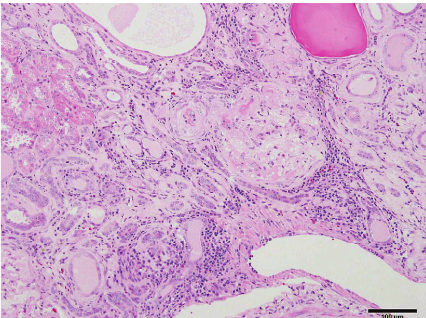
F 4: Histological analysis. HE stain. Severely progressed glomerular and tubulointerstitial lesions in male SDT fatty rat at 60 weeks of age ere are completely sclerotic glomeruli and atrophic tubules with many in�ammatory cells in the interstitum. Bar